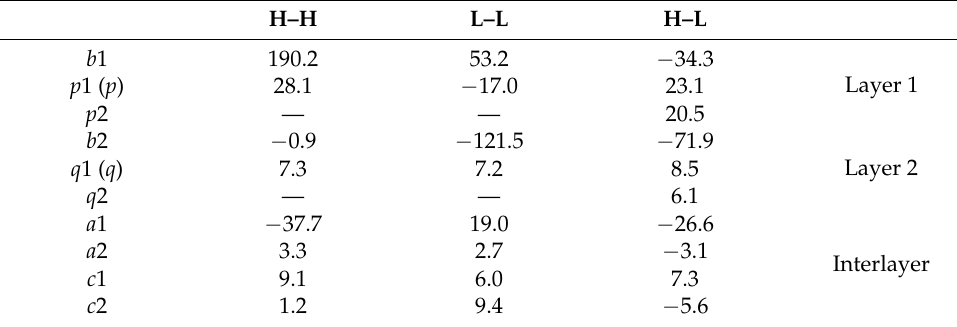
Table 2. HOMO–HOMO (H–H), LUMO–LUMO (L–L), and HOMO–LUMO (H–L) transfer integrals (meV) at 7.8 GPa (Structure